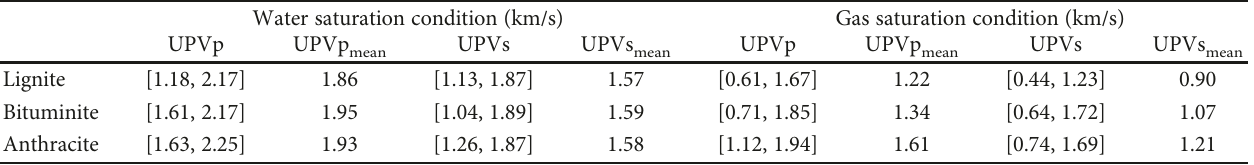
Table 2: UPVp and UPVs velocity ranges and the mean values of three ranks of coals. Water saturation condition